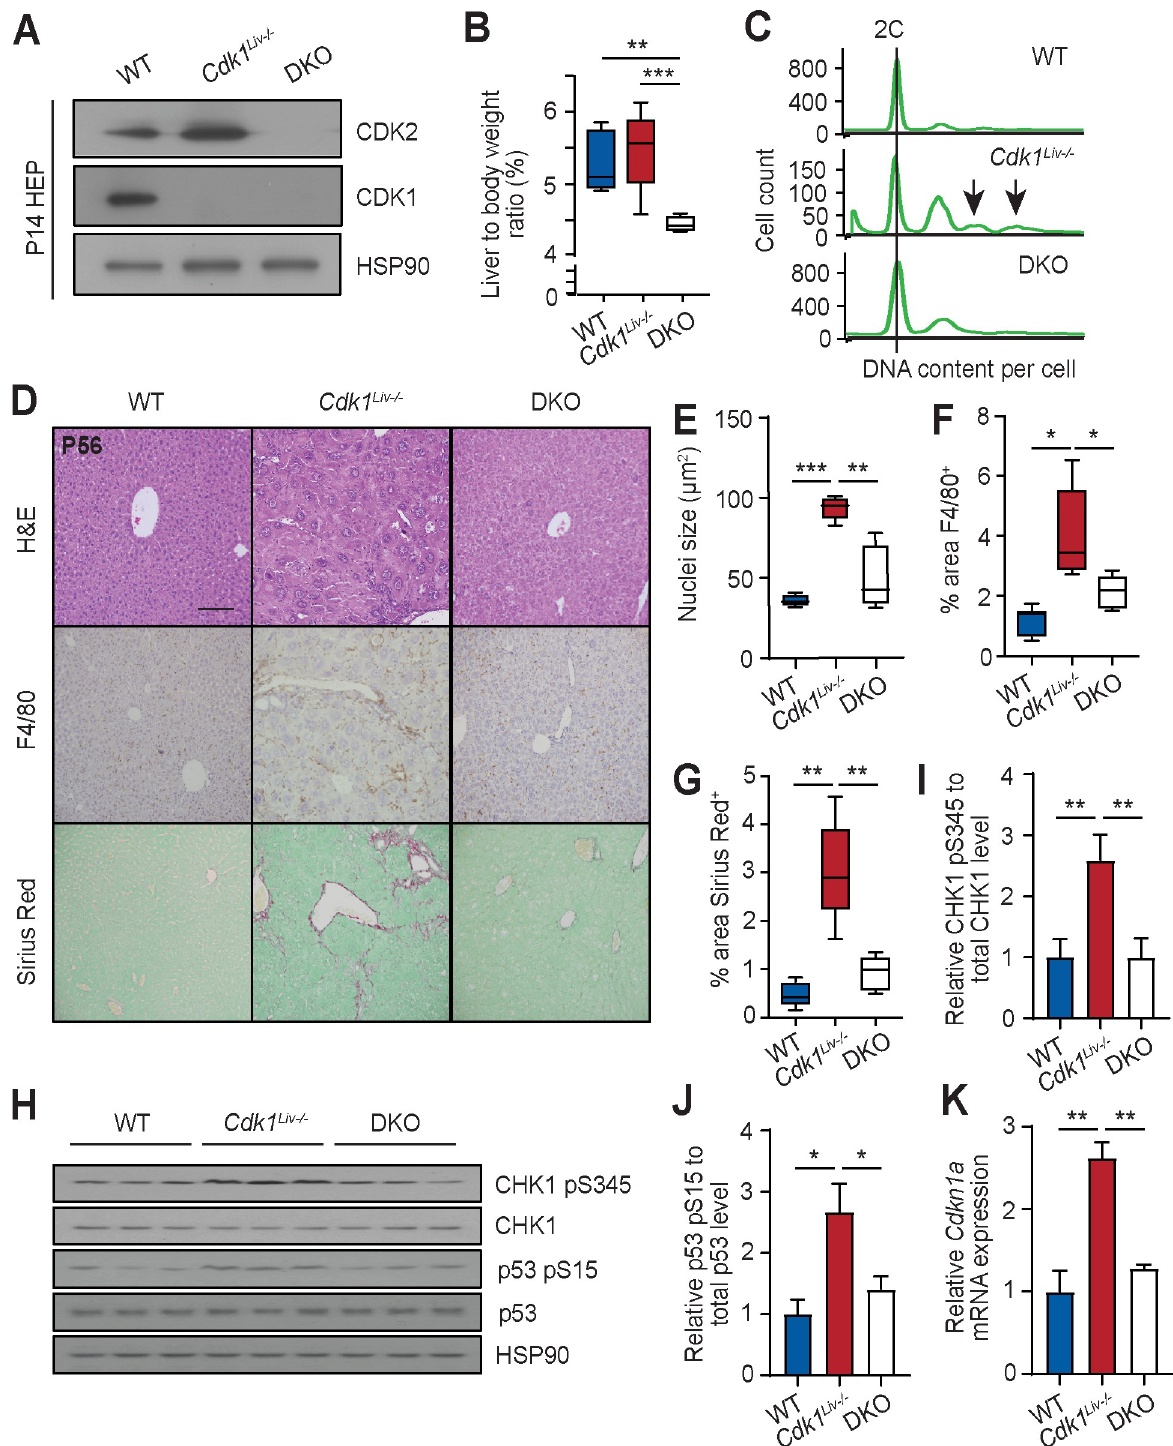
Fig 7. Cdk2 knockout rescues phenotype of Cdk1 Liv-/- liver. (A) Immunoblot of lysates from P14 hepatocytes isolated from wild type (WT), Cdk1 Liv-/- and double knockout (DKO) mice, probed for CDK1 and CDK2 with HSP90 as loading control. (B) Ratio of liver weight to body weight, shown in percentage [%] (at least n = 4 per genotype). Error bars represent S.D. (C) DNA content analysis by flow cytometry of propidium iodide- stained hepatocytes isolated from wild type (WT), Cdk1 Liv-/- , and double knockout (DKO) mice at P14. (D) Representative H&E images, immunohistochemistry images of sections stained for F4/80 (brown), and Sirius Red-stained images of liver sections. (E) Quantification of nuclei